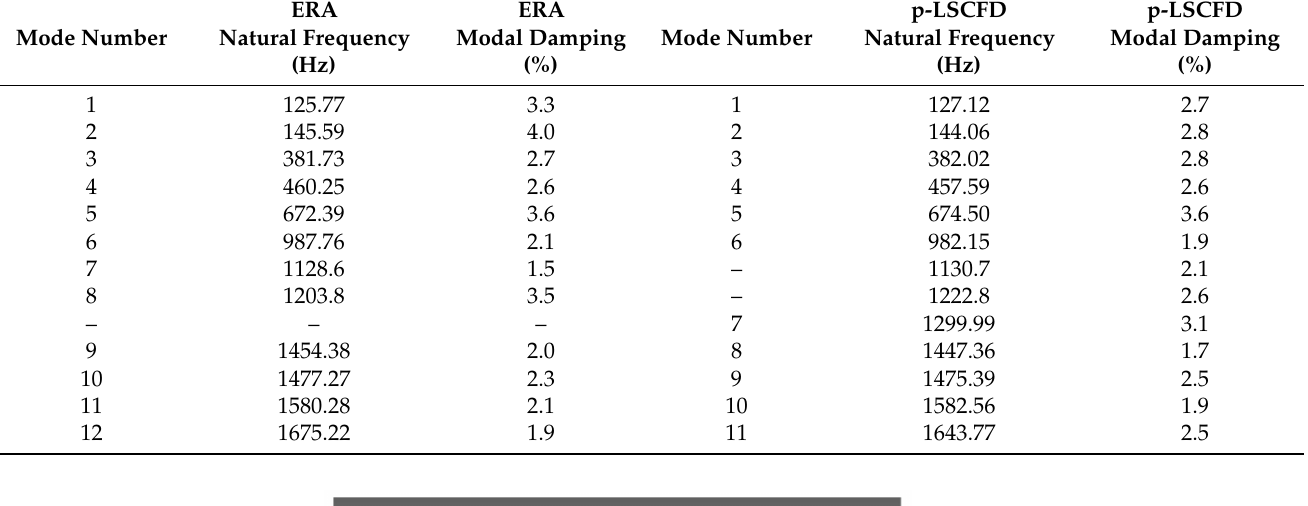
Table 1. Natural frequencies and modal damping coefficients of the identified normal modes of CoroBore 825 XL boring tool.